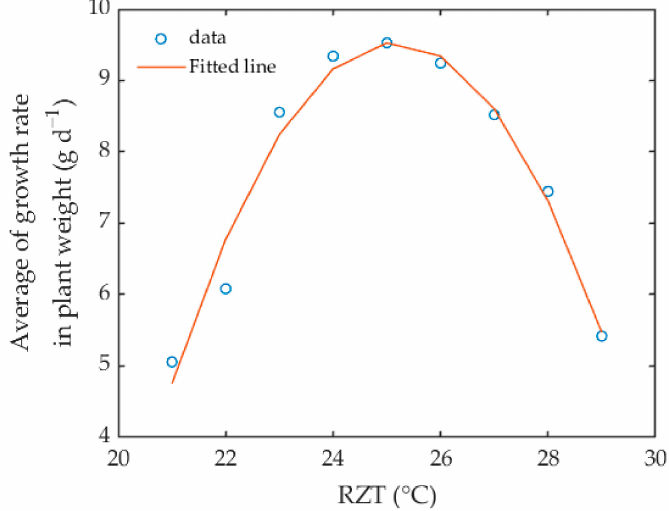
Figure 9. The estimated static relationship between the growth rate of plant weight and RZT, obtained via